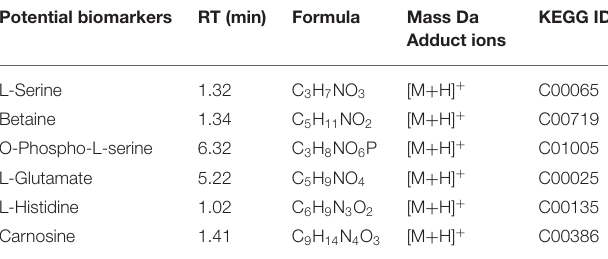
TABLE 2 | Potential biomarkers of physiological